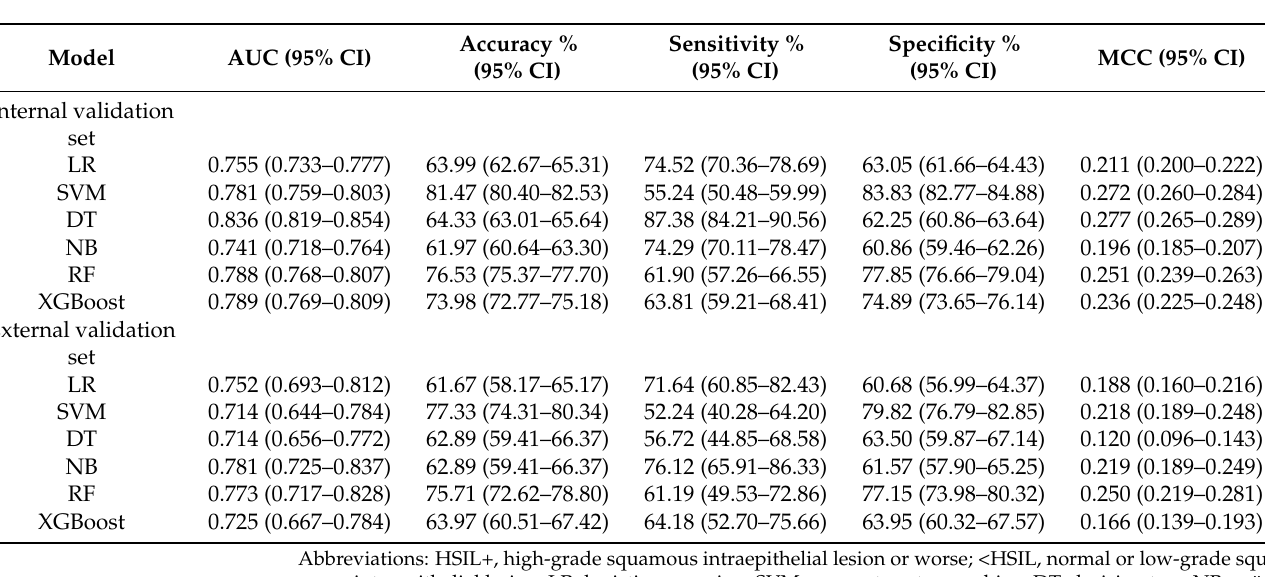
Table 4. Performance of different models for detecting HSIL+ among patients diagnosed as <HSIL by colposcopists.